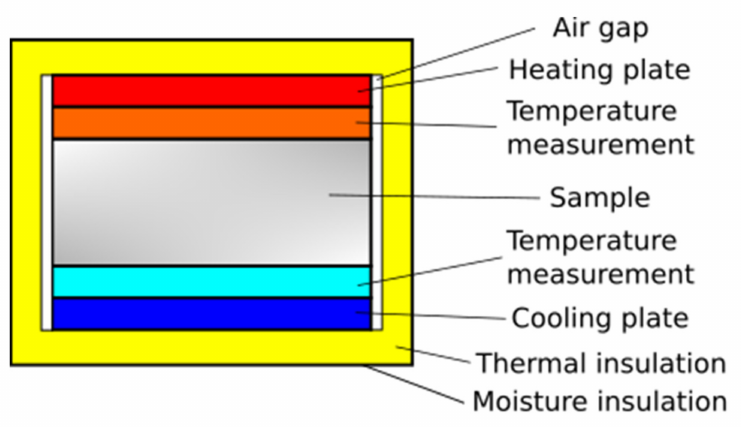
Figure 3. Calorimeter schematic